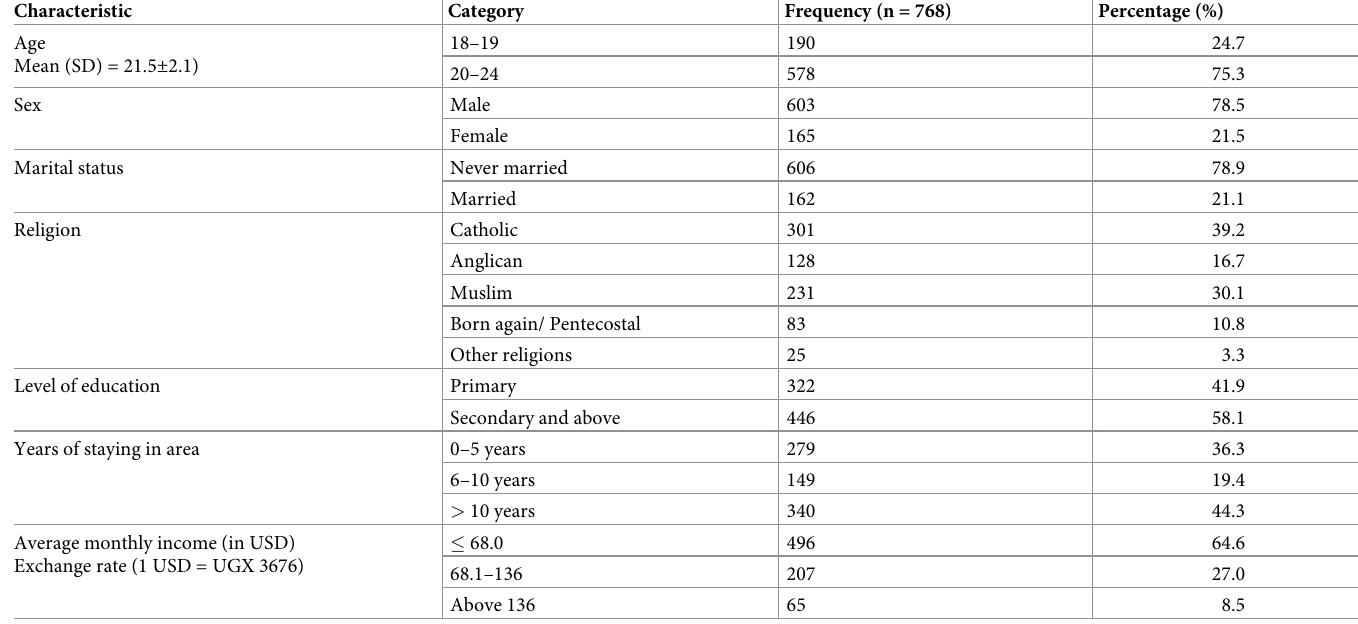
Table 1. Background characteristics of the psychoactive substance users in Kampala’s informal settlements. Characteristic Category Frequency (n = 768) Percentage (%) Age Mean (SD) = 21.5 ±